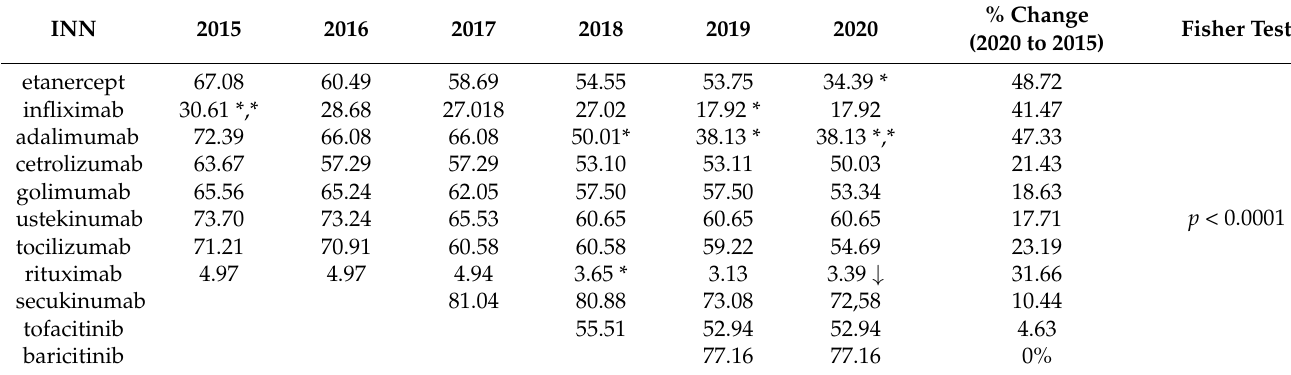
Table 2. Reference price per define daily dose (DDD) for anti-inflammatory joint diseases medicines